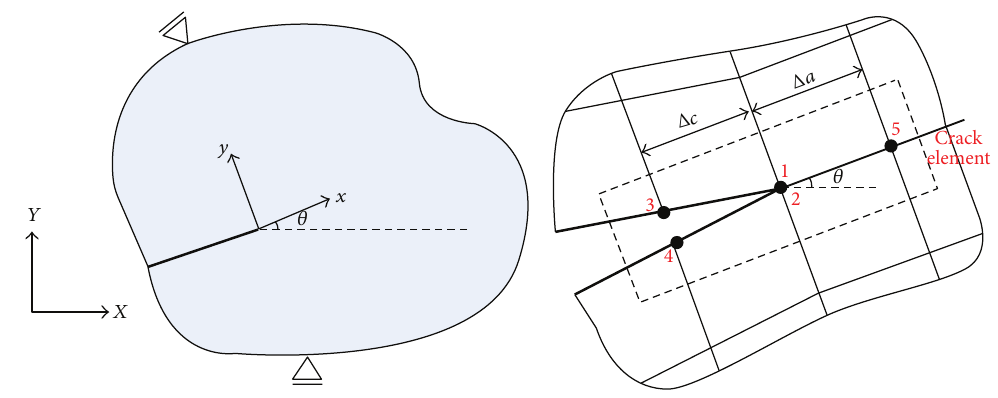
Figure 3: Fracture dummy node